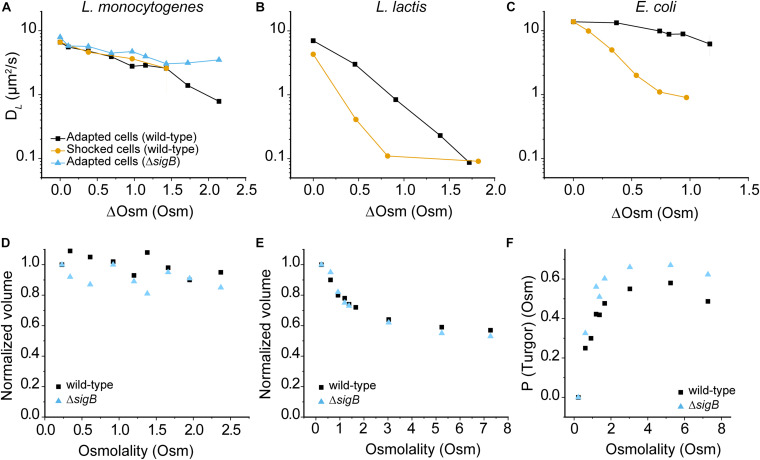
Effect of hypertonicity on the diffusion of GFP, cell volume and turgor pressure. (A)
DL of GFP in osmotically-adapted and shocked cells of L. monocytogenes EGE-e and EGD-e ΔsigB. Panels (B) and (C) show similar data for L. lactis and E. coli, taken from Konopka et al., 2009 and Mika et al., 2014. Median values of DL are used for L. monocytogenes and L. lactis; and mean values for E. coli. Details of interquartile ranges and standard deviations are presented in the Supplementary Table 2. In all cases cells were grown in chemically defined media with initial medium osmolalities of 0.23, 0.53, and 0.28 Osm for L. monocytogenes, L. lactis, and E. coli, respectively; ΔOsm reflects the addition of NaCl to these media. (D) and (E) panels show the normalized volume of L. monocytogenes EGD-e and EGD-e ΔsigB of osmotically-adapted (D) and shocked cells (E); a minimum of 100 (up to 800) cells were analyzed for each condition. A value of 1 corresponds to a volume of 0.61 μm3 and 0.76 μm3 for L. monocytogenes EGD-e wild-type and ΔsigB cells, respectively. (F) Turgor pressure plots of L. monocytogenes EGD-e wild-type and ΔsigB.